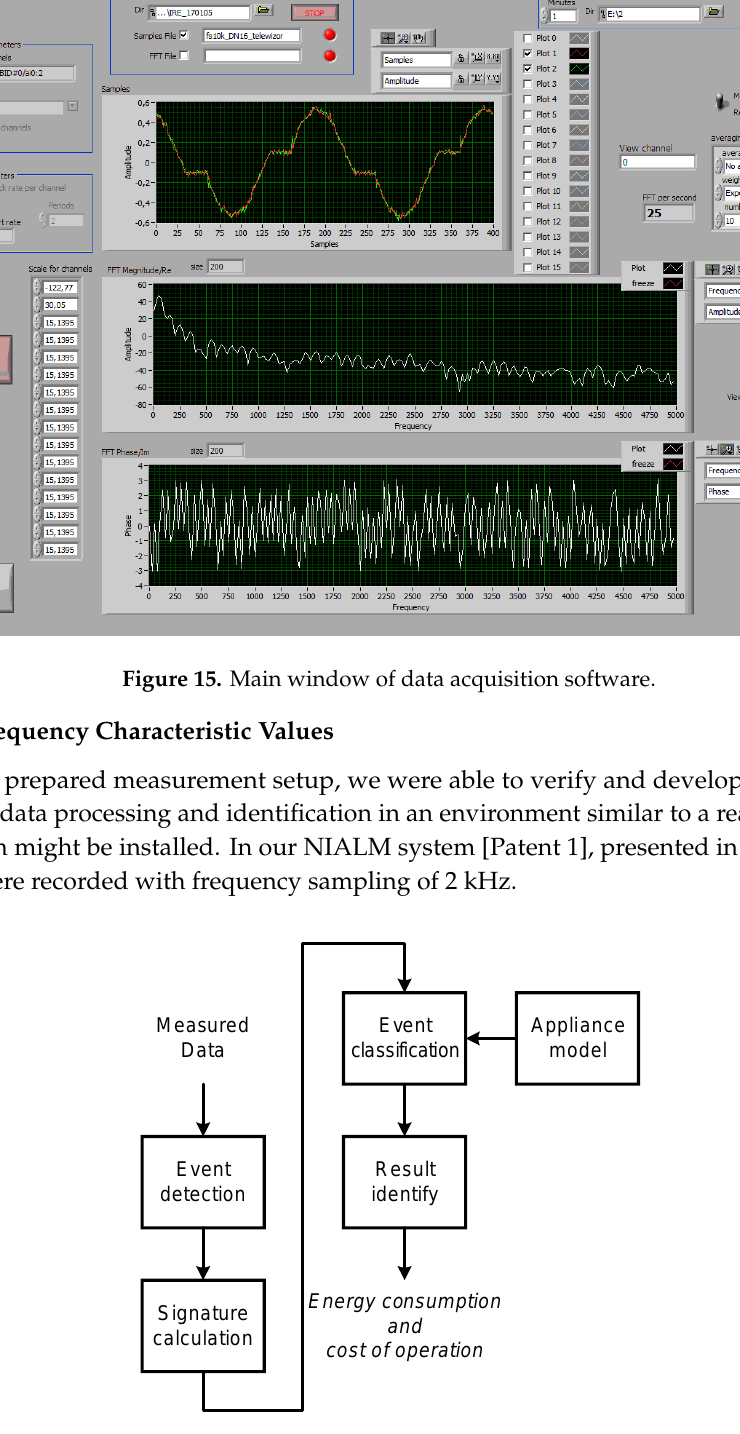
Figure 16. The proposed NIALM architecture.